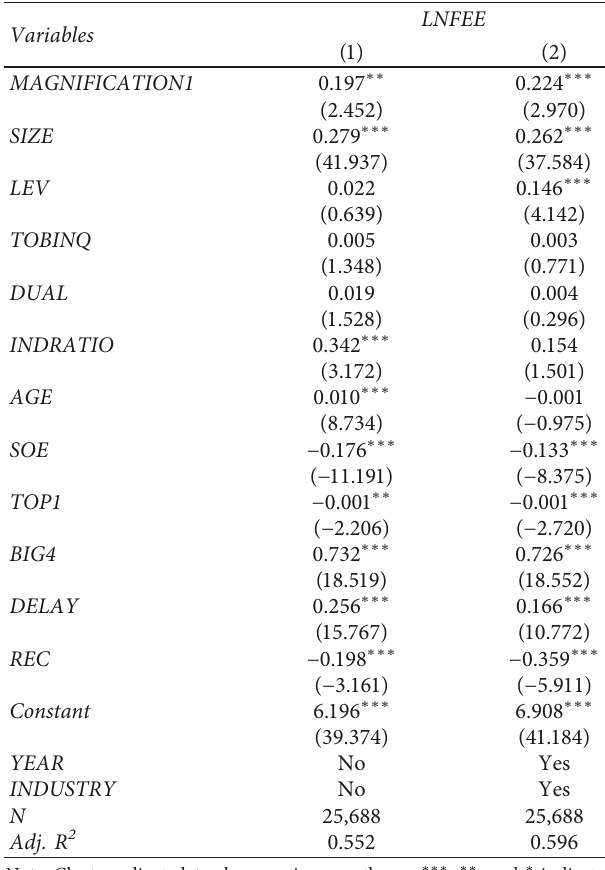
Table 5: The impact of amplification effect on audit